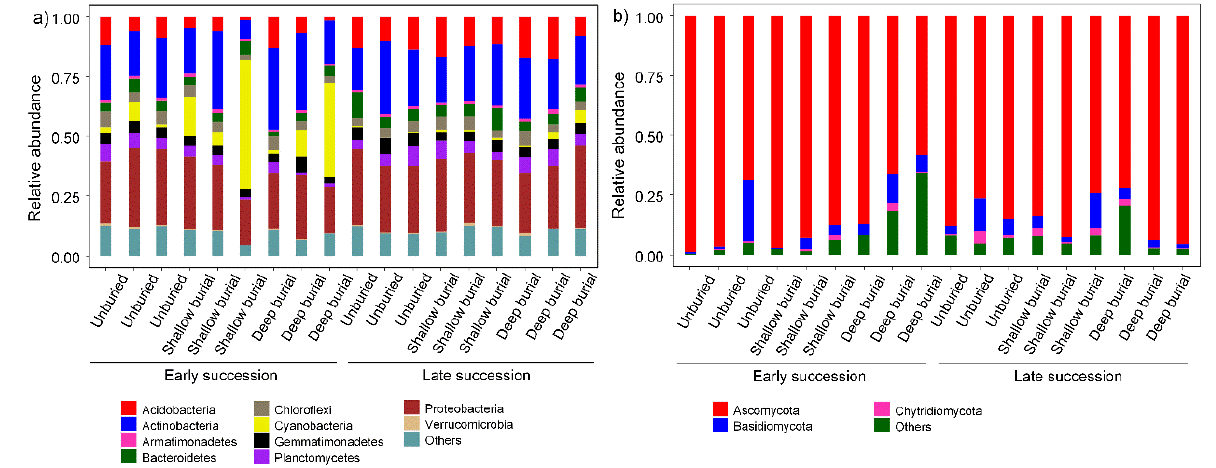
Figure 3. The community composition of bacteria ( a ) and fungi ( b ) at the phylum level in the present study.